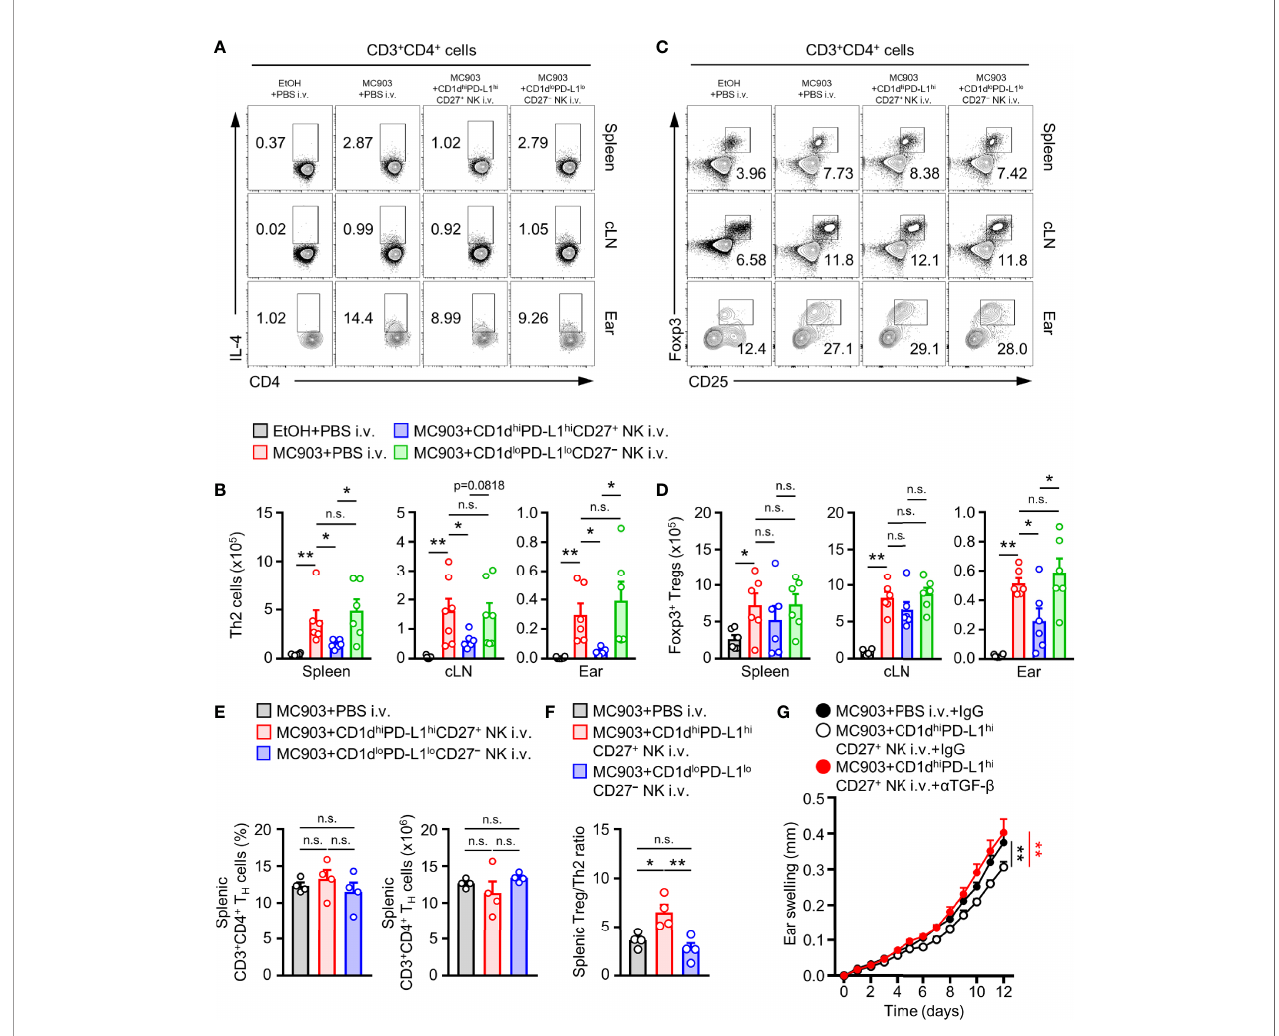
FIGURE 6 | Adoptive transferred TGF- b -producing NK subsets suppresses T H 2 response and helps balance between effector and regulatory T cells. (A) Representative fl ow cytometry images and (B) histograms for the number of T hi PD-L1 hi CD27 + or H 2 cells in spleen, cLN, and ear from AD mice after adoptive transfer CD1d CD1d lo PD-L1 lo CD27 – NK subset (n = 6). (C) Representative fl ow cytometry images and (D) histograms for the number of T H 2 cells in spleen, cLN, and ear from AD mice (n = 6). (E) Histograms for the frequency and number of total T H cells in spleen from AD mice with or without transfer of CD1d hi PD-L1 hi CD27 + or CD1d lo PD-L1 lo CD27 – NK subset. (F) Histograms showing the ratio of Foxp3 + Treg cells per IL-4 + T H 2 cells from spleen tissues as indicated (n = 4). Data are expressed as mean ± SEM. * p < 0.05; ** p < 0.01; n.s., not signi fi cant. (G) The ear thickness of CD1d hi PD-L1 hi CD27 + NK subset transferred MC903- induced AD mice with or without anti-TGF- b mAb treatment are shown (n = 7). The results are expressed as the mean ± SEM from two independent experiments. ** P < 0.01 versus MC903+PBS i.v.+IgG (black**) or MC903+CD1d hi PD-L1 hi CD27 + NK i.v.+ a TGF- b mAb